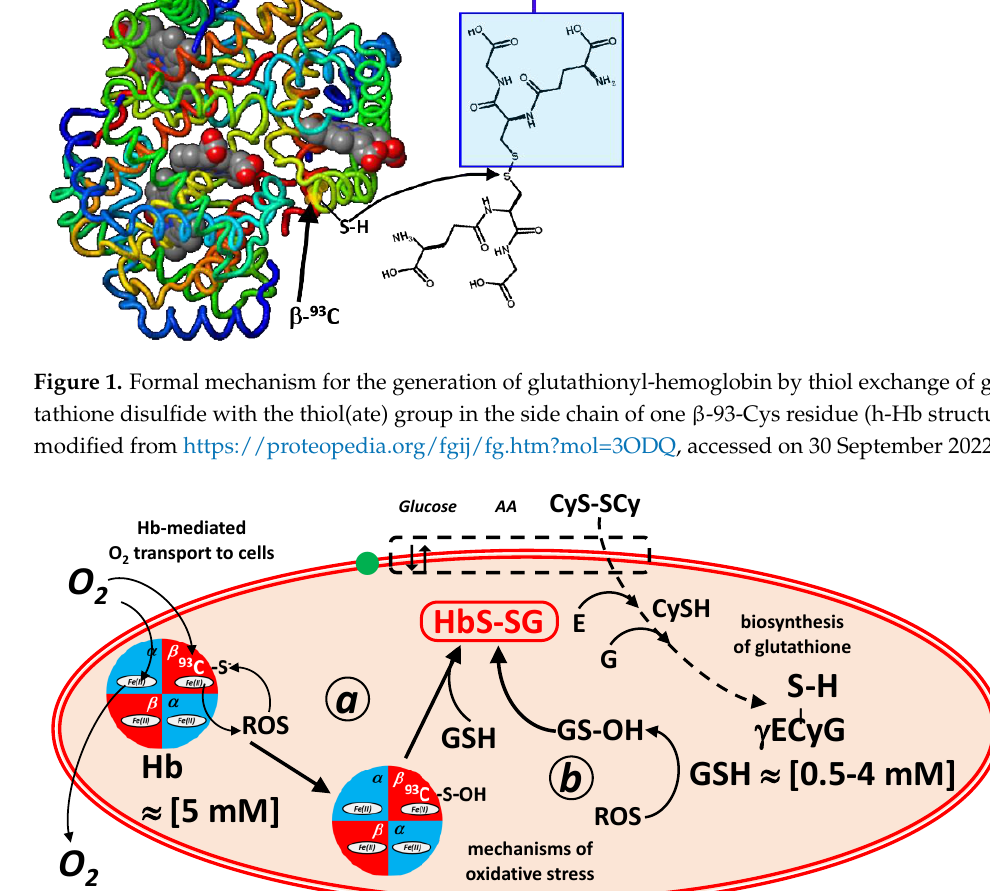
Figure 2. Formal mechanisms of generation and coping of oxidative stress in red blood cells mediated by hemoglobin and glutathione redox buffers. In mechanism a , oxy-hemoglobin generates Reactive Oxygen Species (ROS, such as hydrogen peroxide) that convert by oxidation the 93 β -Cys residue into the corresponding sulphinic acid. The hemoglobin sulphinic acid reacts with glutathione (GSH; γ ECyG) to generate glutathionyl-hemoglobin. In mechanism b , ROS oxidize glutathione to glutathione sulphinic acid (GS-OH), which reacts with the 93 β -Cys residue of hemoglobin, again to generate glutathionyl-hemoglobin. Highlighted are (left) the transport of O 2 to the cells, mediated by hemoglobin, and (right) the biosynthesis of glutathione in erythrocytes from the constituent amino acids, glutamic acid (E), glycine (G) and cysteine (CySH), which is imported as its disulfide, cystine (CyS-SCy).